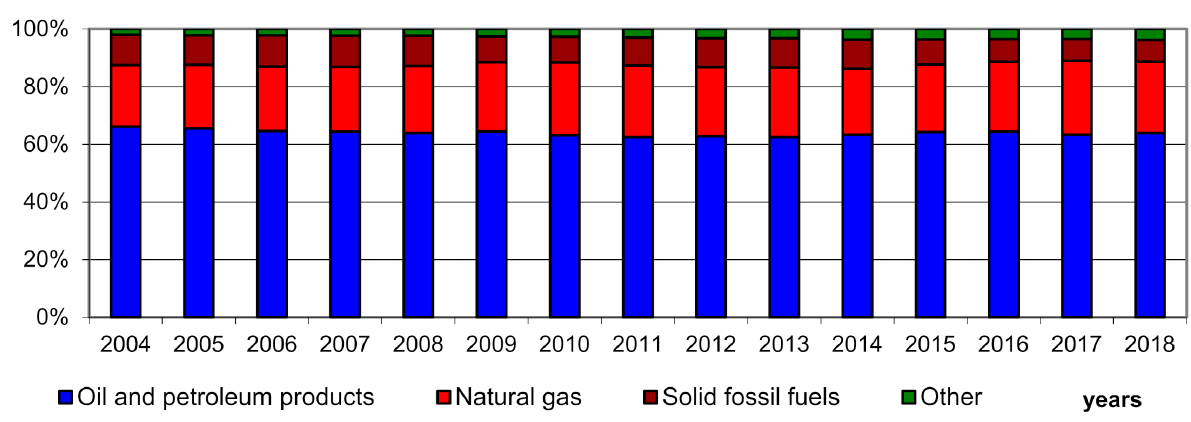
Figure 3. The structure of energy imports in the European Union according to the most important sources in